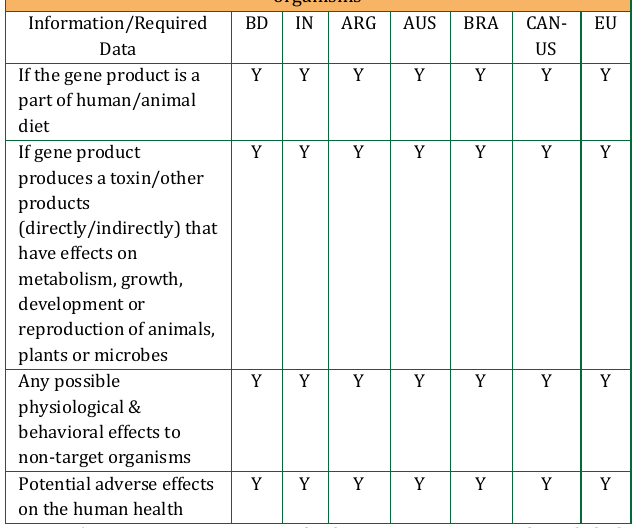
Table 7: Data requirement of potential adverse effects on non-target